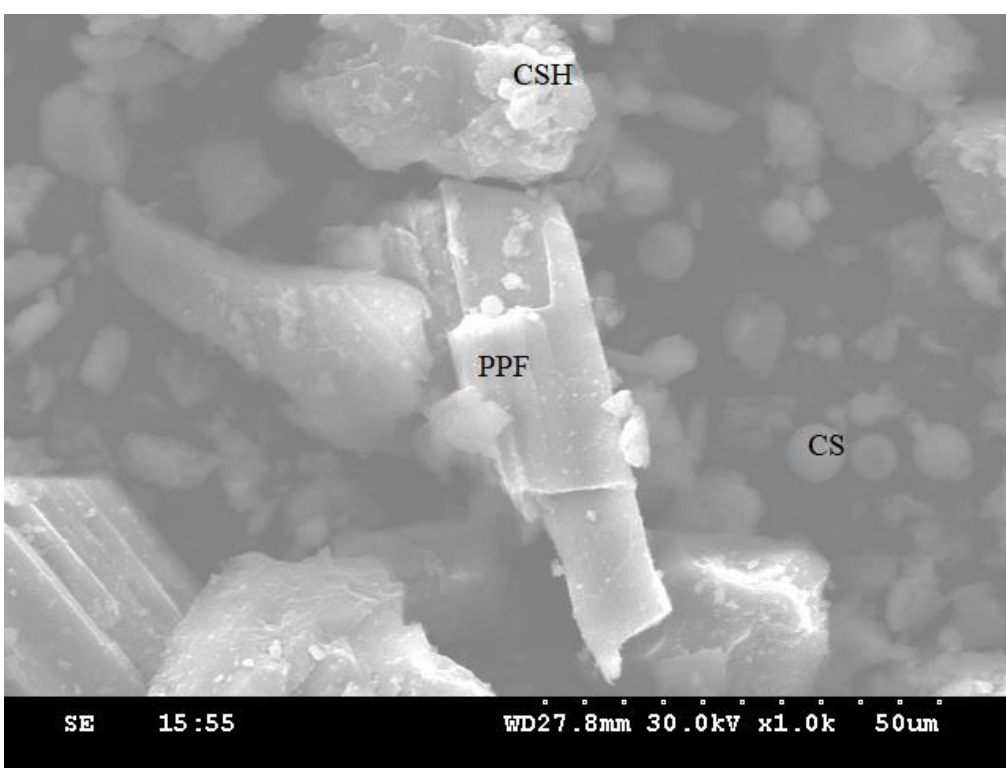
Figure 10. SEM image of control concrete.